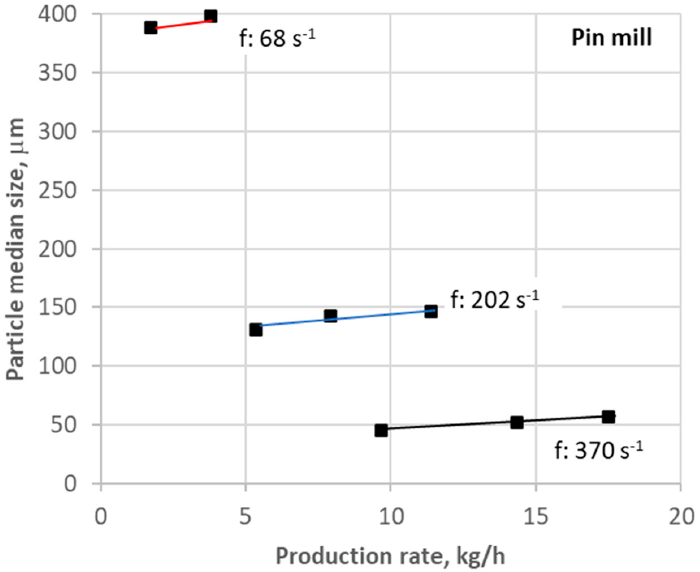
Figure 5. Dependence of particle size on production rate at three levels of rotor frequency (f: 68 s − 1 , 202 s − 1 , and 370 s − 1 ) in pin milling.